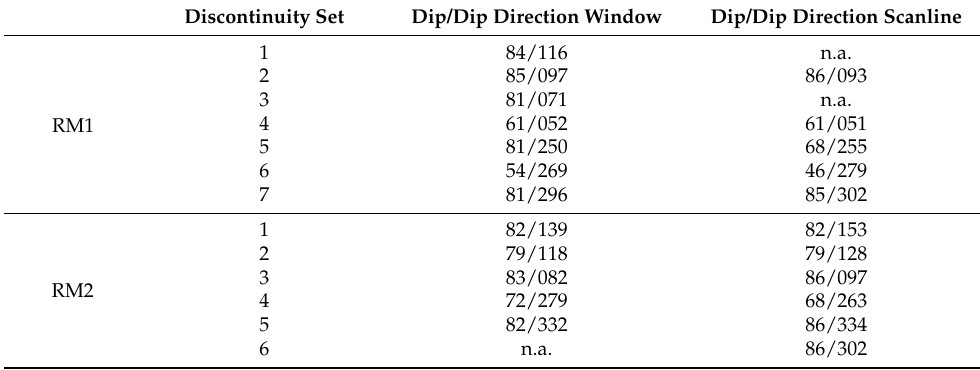
Table 1. List of the discontinuity sets extracted by K-D tree algorithm through both survey window and scanline; n.a. is reported when the corresponding discontinuity set was not